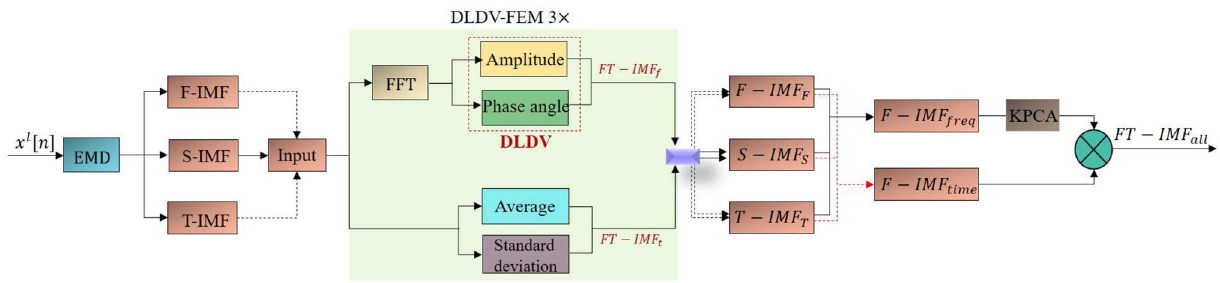
Fig. 2 The process of DLDV feature extraction and dimensionality reduction. Note that we process the ECG through two stages (EMD and FFT), we then focus on the depth local features of the secondary